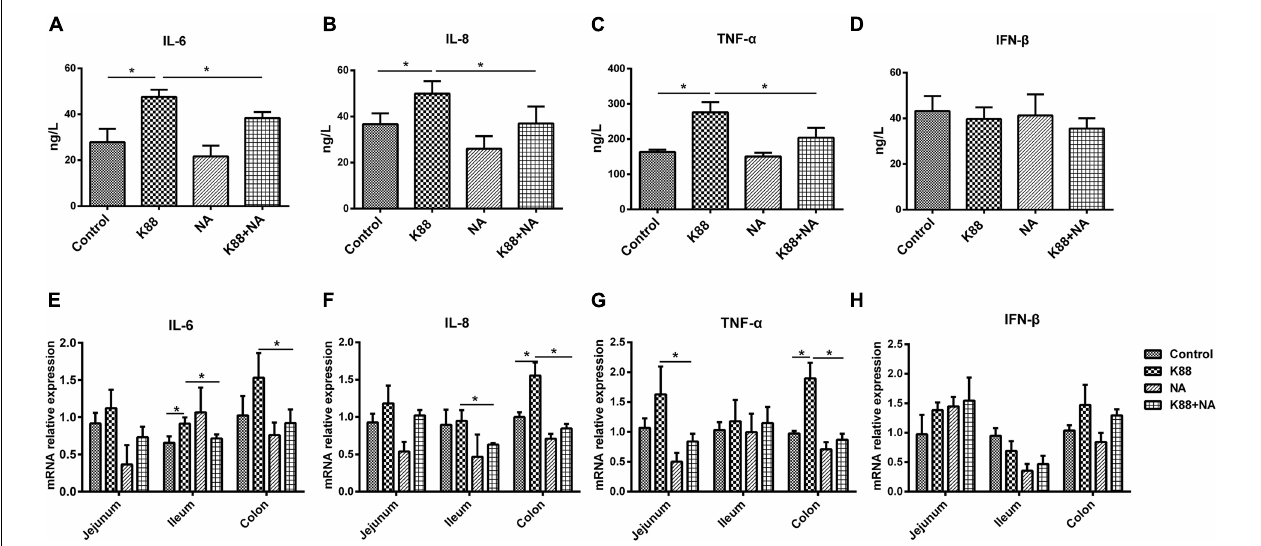
FIGURE 2 | Nicotinic acid ameliorated the inflammation caused by E. coli infection in intestinal tissues and serum of weaned piglets. The level of serum IL-6 (A) , IL-8 (B) , TNF- α (C) , and IFN- β (D) were determined via ELISA. The relative mRNA expression levels of IL-6 (E) , IL-8 (F) , TNF- α (G) , and IFN- β (H) in the jejunum, ileum, and colon were determined via real-time PCR. All data are expressed as the mean ± SEM. * P < 0.05.